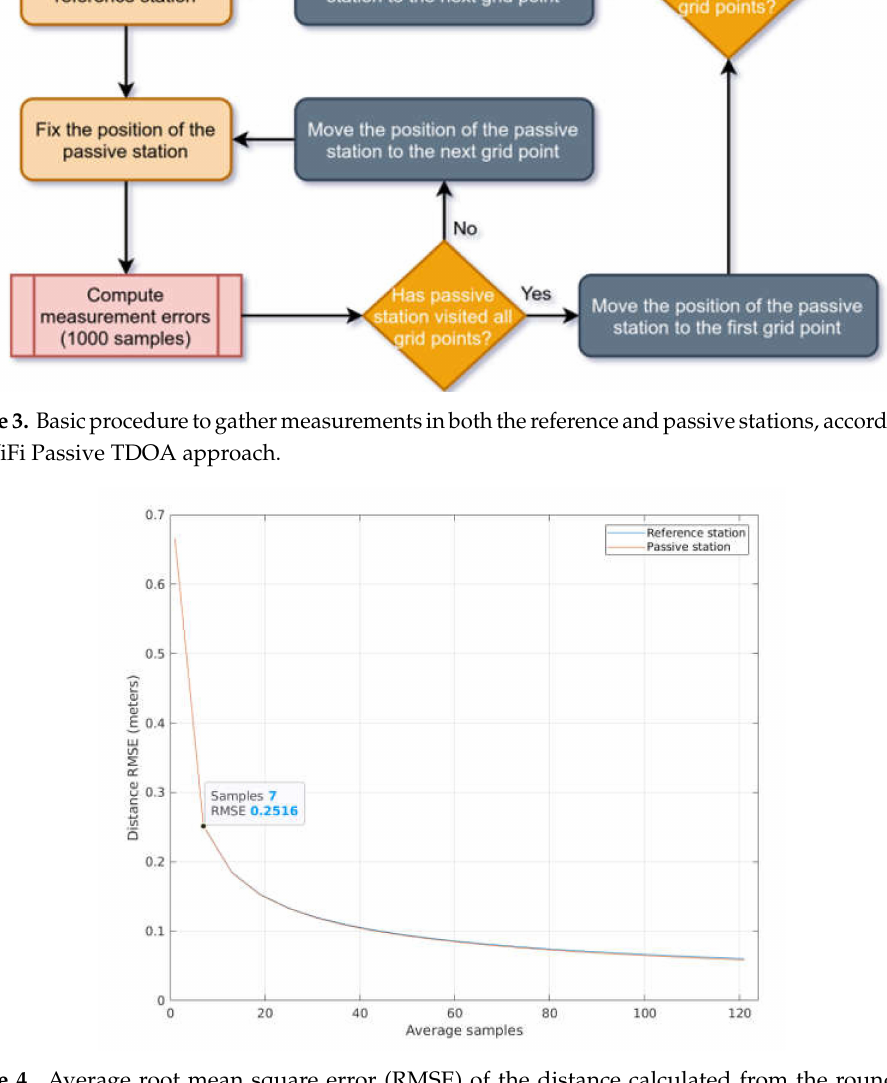
Figure 4. Average root mean square error (RMSE) of the distance calculated from the round trip time (RTT) and time-di ff erence of arrival (TDOA) measurements for IEEE 802.11mc and the